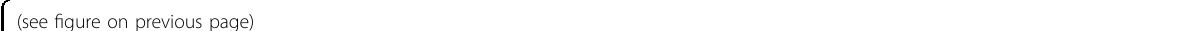
Fig. 5 miR-135b mediates the regulation of FOXO1 by ATF3 during decidualization. A hESCs were transfected with Ad-ATF3-his (0 or 40 MOI) or Ad-LacZ. si-Dicer was used to knockdown the expression of Dicer, and prolactin secretion was measured by ELFA. * P < 0.05, ** P < 0.01, *** P < 0.001. B , C miRNA array and qPCR were performed to detect the differentially expressed miRNAs in RIF patients. Data were downloaded from the GEO database (GSE71332). The expression of miR-135b was validated by qPCR and normalized to U6 expression ( n = 9 for FER group and 12 for RIF group, * P < 0.05). D The correlation of ATF3 expression and miR-135b with the data in B . E hESCs were transfected with Ad-ATF3-his (0, 20, or 40 MOI) or Ad- LacZ. miR-135b expression levels were analyzed by qPCR. * P < 0.05. F GSEA results showed that the AAGCCAT miR-135B term was activated after overexpression of ATF3. G hESCs were treated with 8-Br-cAMP + MPA for different times, and then the expression of miR-135b was measured by qPCR. *** P < 0.001, **** P < 0.0001. H ChIP-PCR was used to detect the binding site of ATF3 on the promotor of miR-135b. I hESCs were transfected with miR-135b mimic (10 nM) or mimic control. After 24 h, the cells were treated with 0.5 mM 8-Br-cAMP and 1 μ M MPA for an additional 3 days. Prolactin released into the medium was measured by ELFA. * P < 0.05, ** P < 0.01, *** P < 0.001. J hESCs were transfected with hsa-miR-135b mimic (0, 5, or 10 nM) or mimic control. FOXO1 protein levels were analyzed by western blot. ** P < 0.01. K , L Putative 7 bp paired miR-135b/a-target sites in the 3 ′ UTR of human FOXO1 mRNA. Analysis of miR-135b modulation of the wild-type and mutant FOXO1 3 ′ UTR luciferase reporter activity. * P < 0.05, ns not signi fi